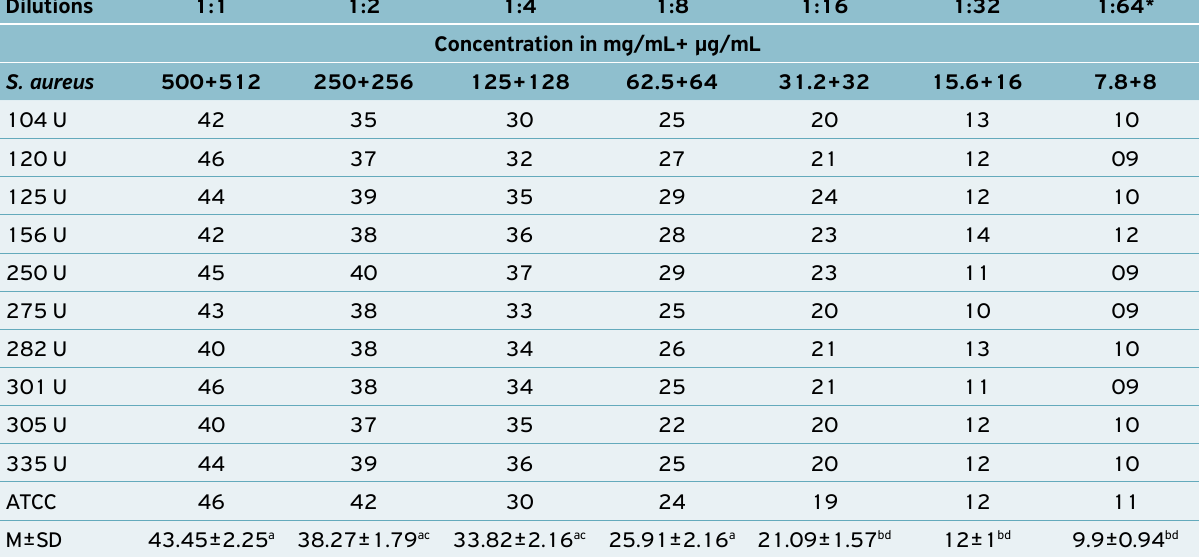
Table 1. Mean±standard deviation of the minimum inhibitory concentration (MIC); with diameters of inhibition halos in millimeters (mm), on solid medium; association of cephalexin with Anacardium occidentale tannin; against Staphylococcus aureus .